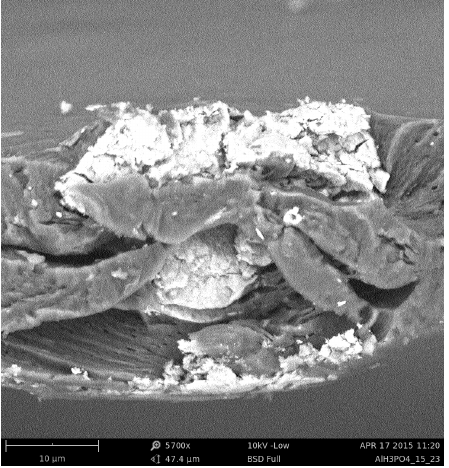
Figure 1. Image of an exemplary alginate membrane, cross-linked by phosphoric acid, containing 15 wt% of magnetite particles